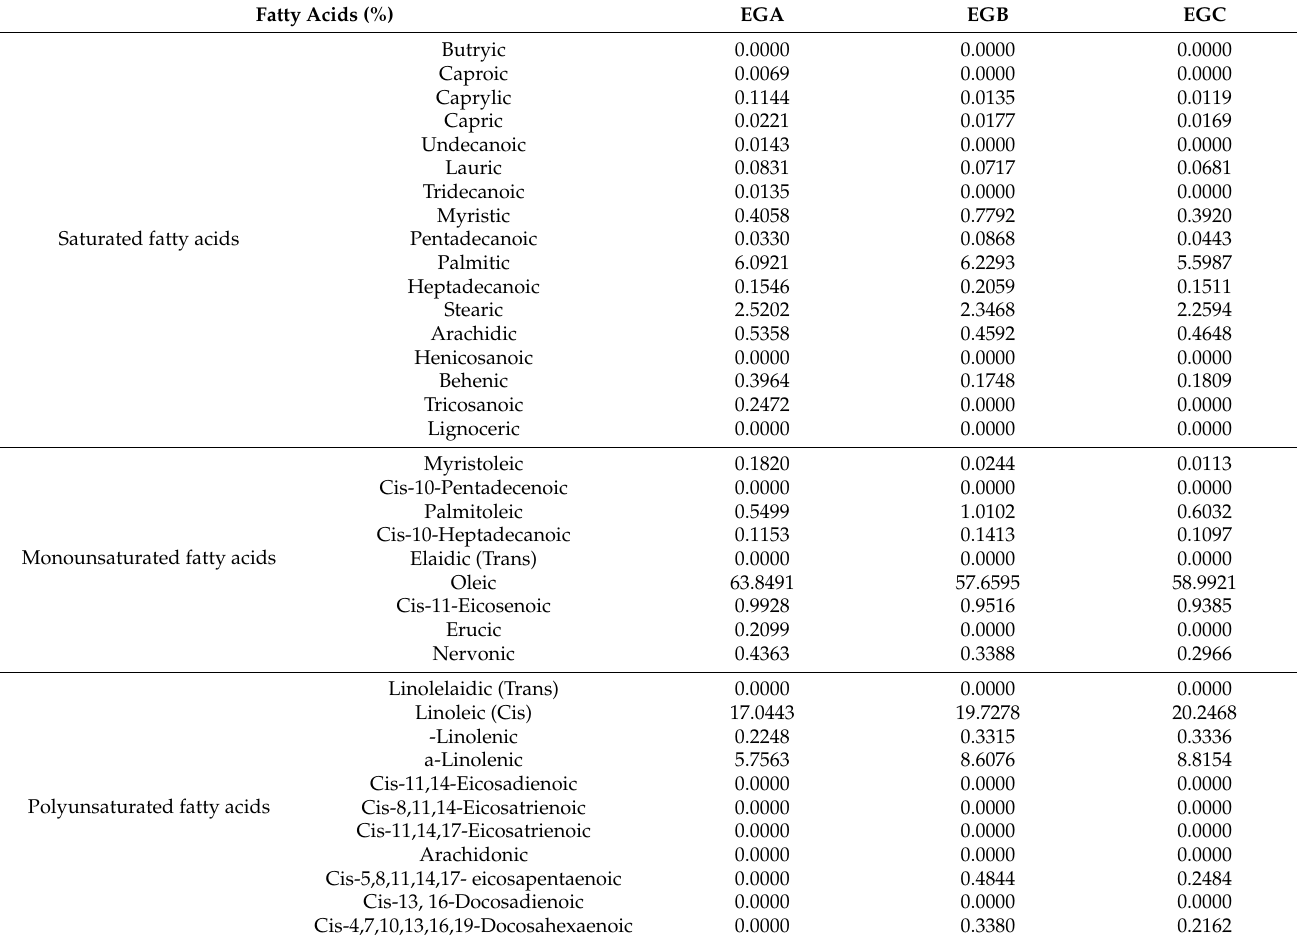
Table 4. Fatty acids profile of EGA, EGB and